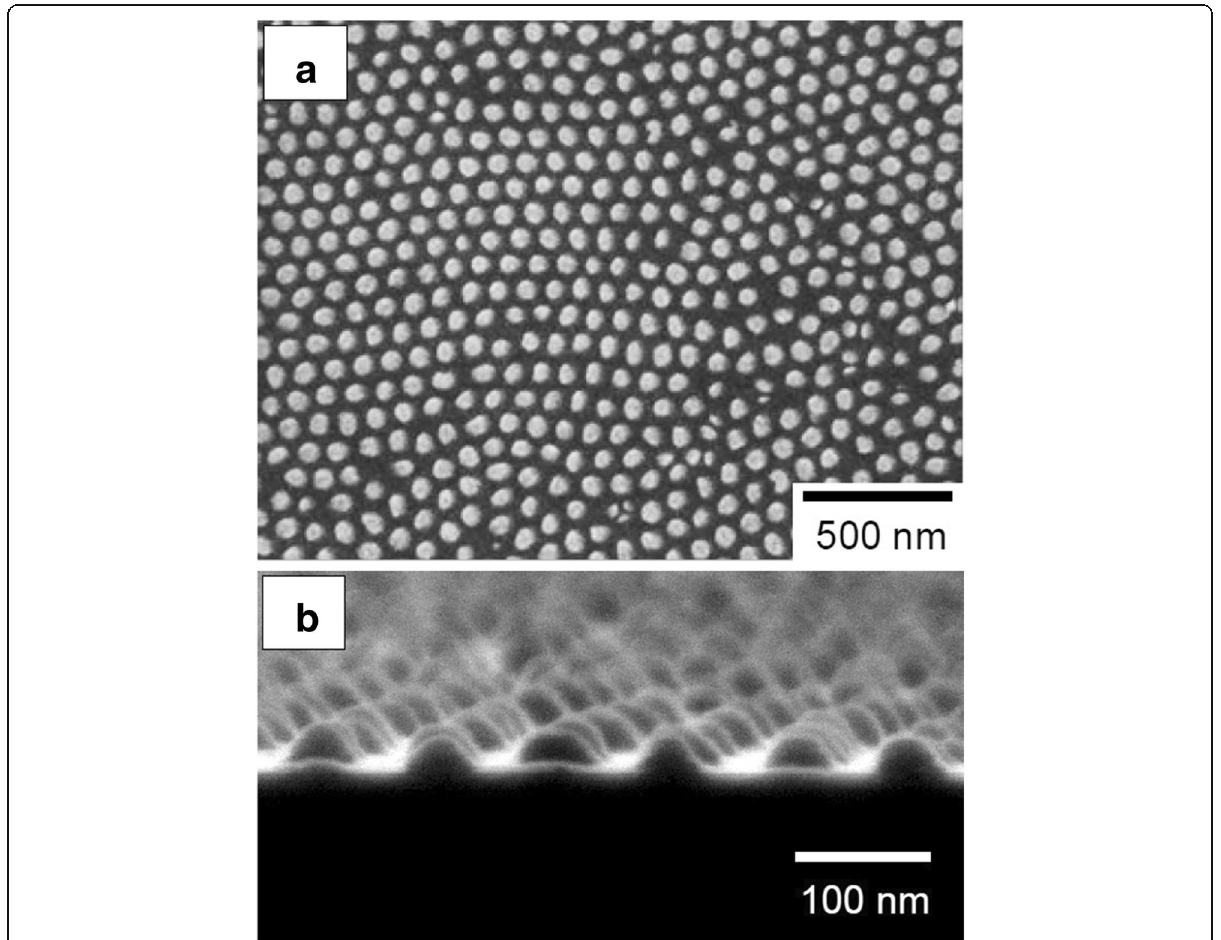
Fig. 2 a Surface and b cross-sectional SEM images of an Au nanodot array formed on a GaAs substrate through an anodic porous alumina